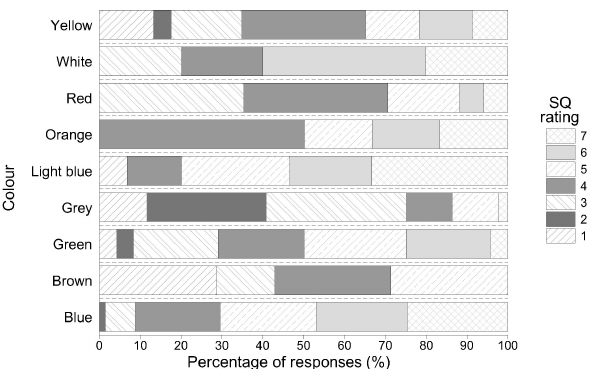
Figure 4: Stacked bar plot of the colours associated with each score given to the soundscape